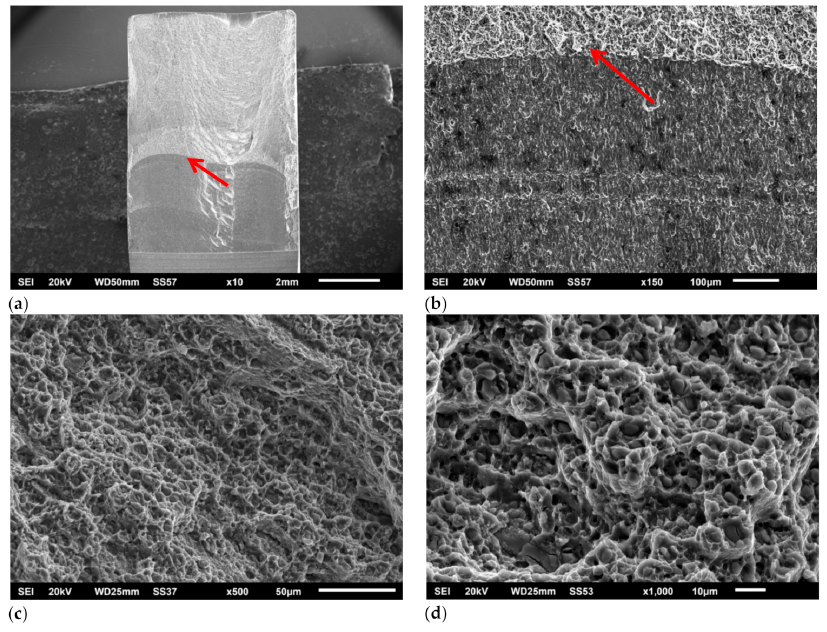
Figure 13. Fracture surface of the B-SZ fracture specimen: ( a ) macro, ( b ) fatigue crack zone and stable crack growth zone, ( c , d ) stable crack growth